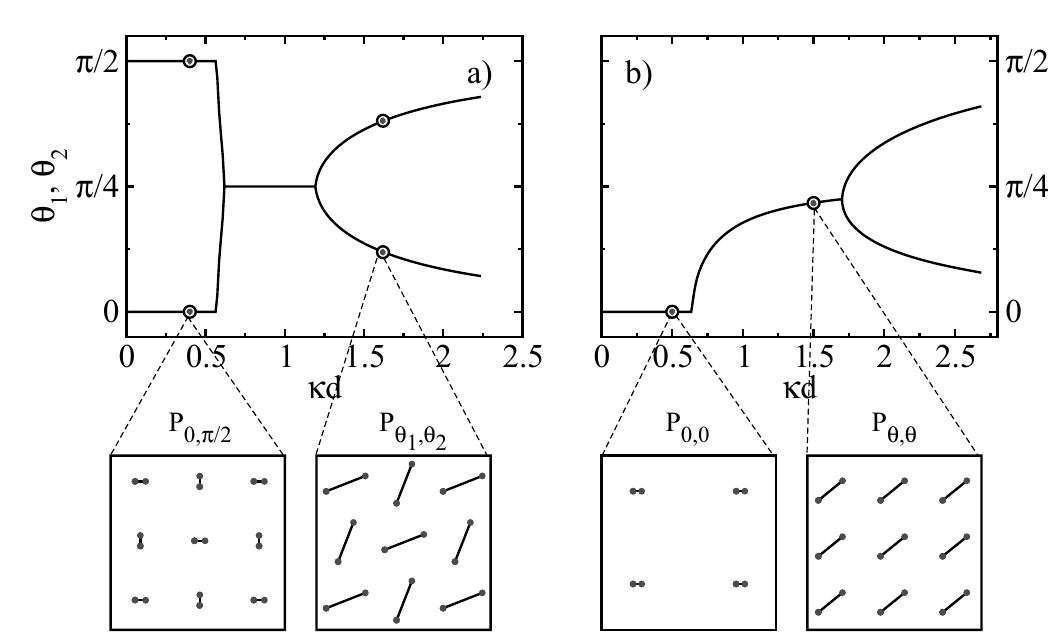
Fig. 3 – Comparison between the ground states for dimers on a square substrate, obtained considering the full “flexible” model including explicitly the trapping potential (results shown with circles), against the restricted approach where the dimers are considered as rigid objects (results shown by the continuous curves). (a) κ l = 4 . 5, α κ l α . 9. The insets display the typical configurations in both rigid and flexible models. = 1 and (b) = 6, = 0